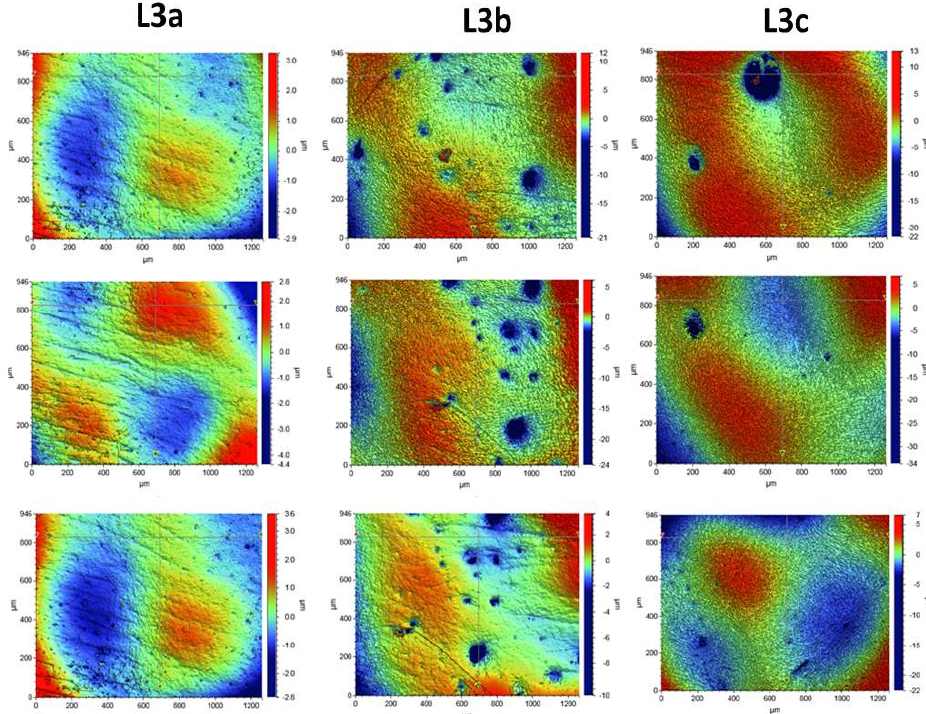
Figure 7. Surface microgeometry maps determined for the K3 composite for 3 variants of laser L3. L3a (periimplantitis variant, sweep technique, 60 s), L3b (periimplantitis variant, sweep technique, 2 × 30 s, with a 60 s cooling pause), and L3c (periimplantitis variant, point technique, 60 s). Table 3. Roughness parameters determined for the K1, K2, and K3 composites before and after the laser irradiation process in three variants: L3a (60 s sweeping), L3b (2 × 30 s sweeping), and L3c (60 s point technique).